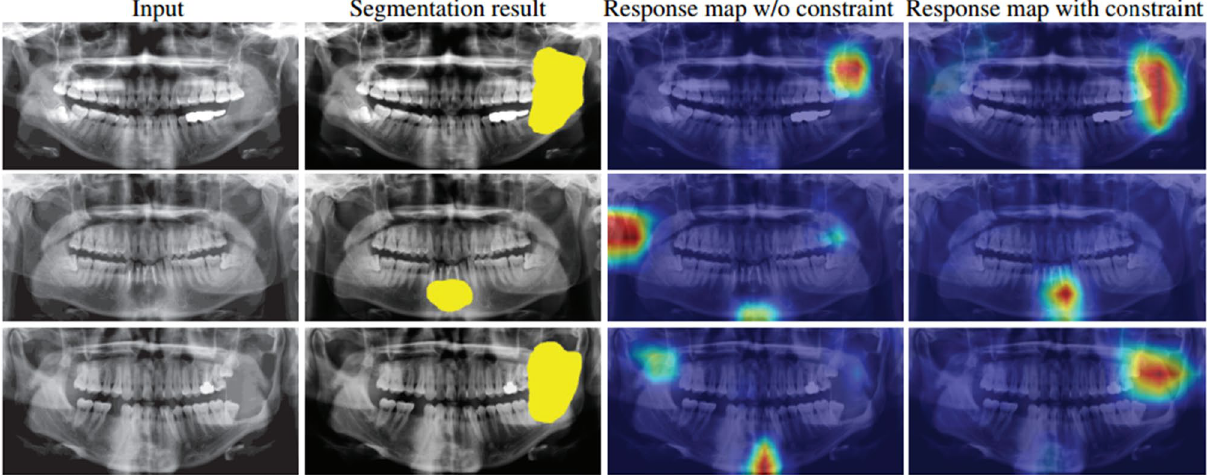
Figure 5. The segmentation results and visual results using Grad-CAM 29 . The segmentation results can locate the lesion areas. The response map can be used as the cause for explaining the classification results. For response maps w/o constraint, there are some inaccurate response areas, which will disturb the final classification and diagnosis. The response maps with the constraint have more concentrated response values than response maps w/o the constraint. With the accurate segmentation results and response maps as references, doctors can further confirm the diagnosis results.